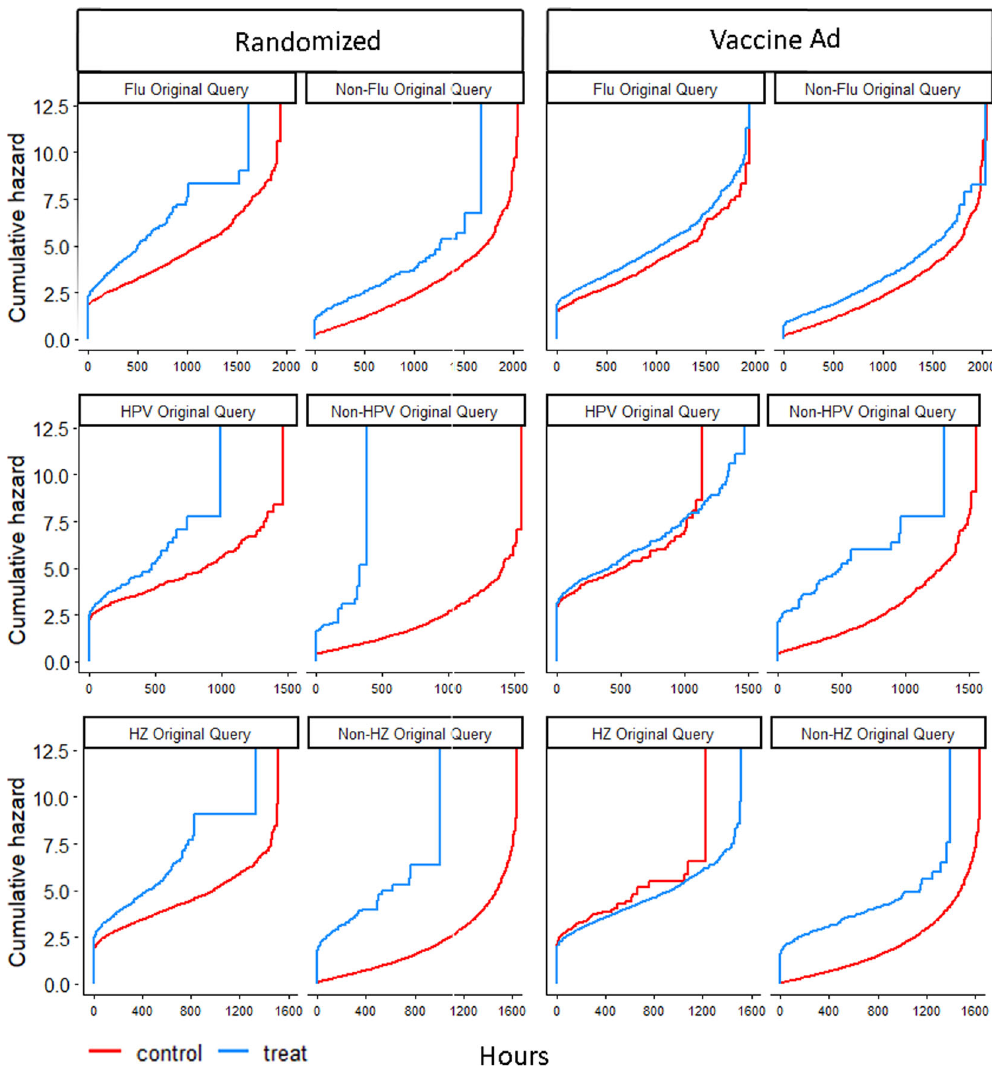
Fig. 2 Cumulative hazard curves for post-ad vaccine searches. The randomized column displays results of the ad experiment, with users who saw our ads counted as “ treated ” . Vaccine Ad column displays results of robustness check, with user who saw any vaccine ad counted as “ treated ”